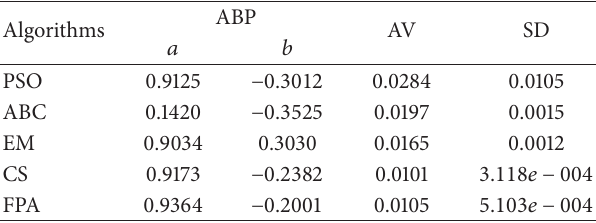
order, 𝑓(𝜃) is multimodal [19]. The error surface 𝑓(𝜃) is shown in Figure 2.